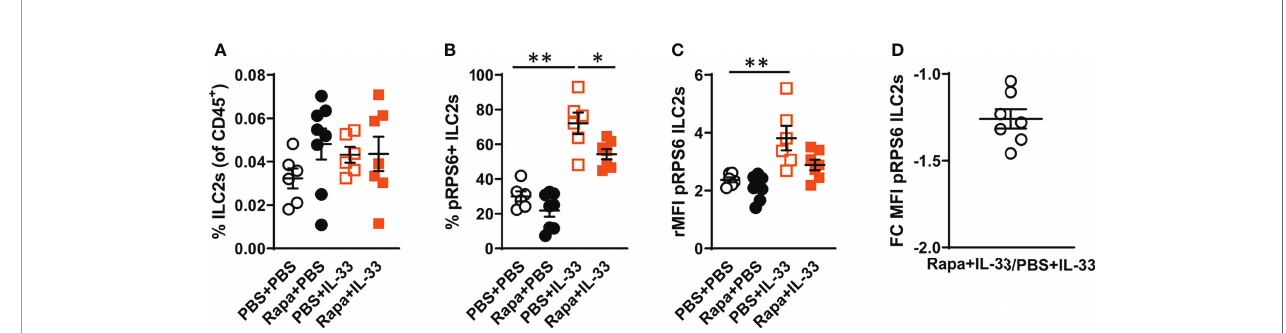
FIGURE 4 | IL-33 induced high mTORC1 activity in bone marrow ILC2s in vivo . (A) Number of ILC2s among all CD45 + leukocytes in the bone marrow. (B) Number of pRPS6 + ILC2s and (C) pRPS6 intensity in ILC2s measured by relative mean fl uorescence intensity (rMFI) in mice exposed to IL-33+rapamycin or PBS. (D) Fold change (FC) rMFI pRPS6 in mice exposed to IL-33+rapamycin and PBS+IL-33. Data are representative of 2 independent experiments (6 – 8/group). Mann-Whitney U test. *P < 0.05 and **P < 0.01. Rapa, Rapamycin; i.p, intraperitoneal; i.n., intranasal; PBS+PBS, PBS i.p. and PBS i.n; Rapa+PBS, Rapa i.p. and PBS i.n.; PBS+IL-